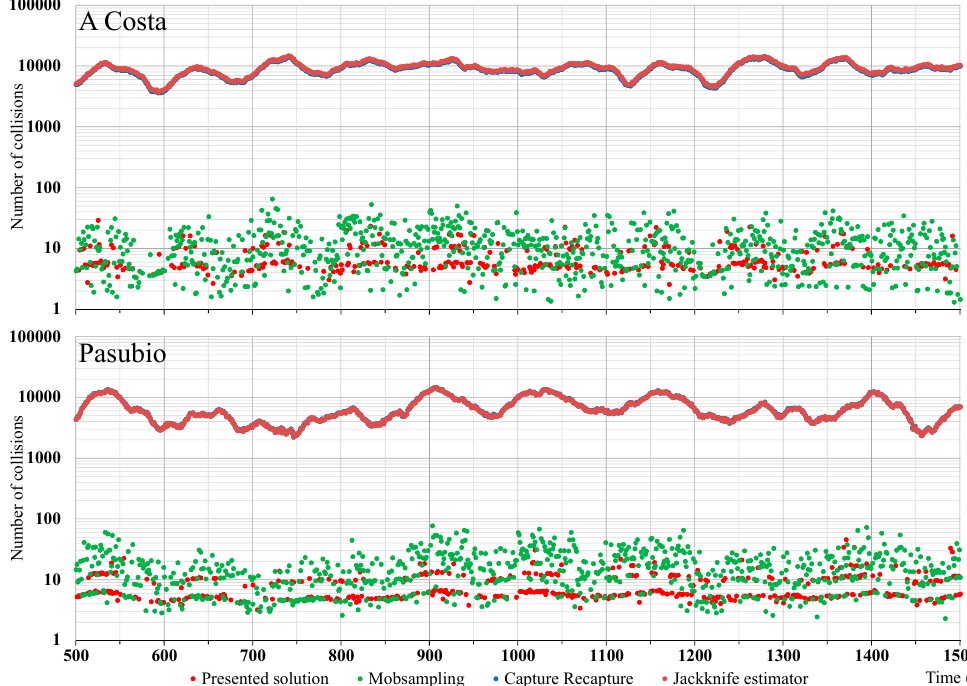
Figure 3. Total number of collisions over time in the most challenging case of 100% penetration rate.